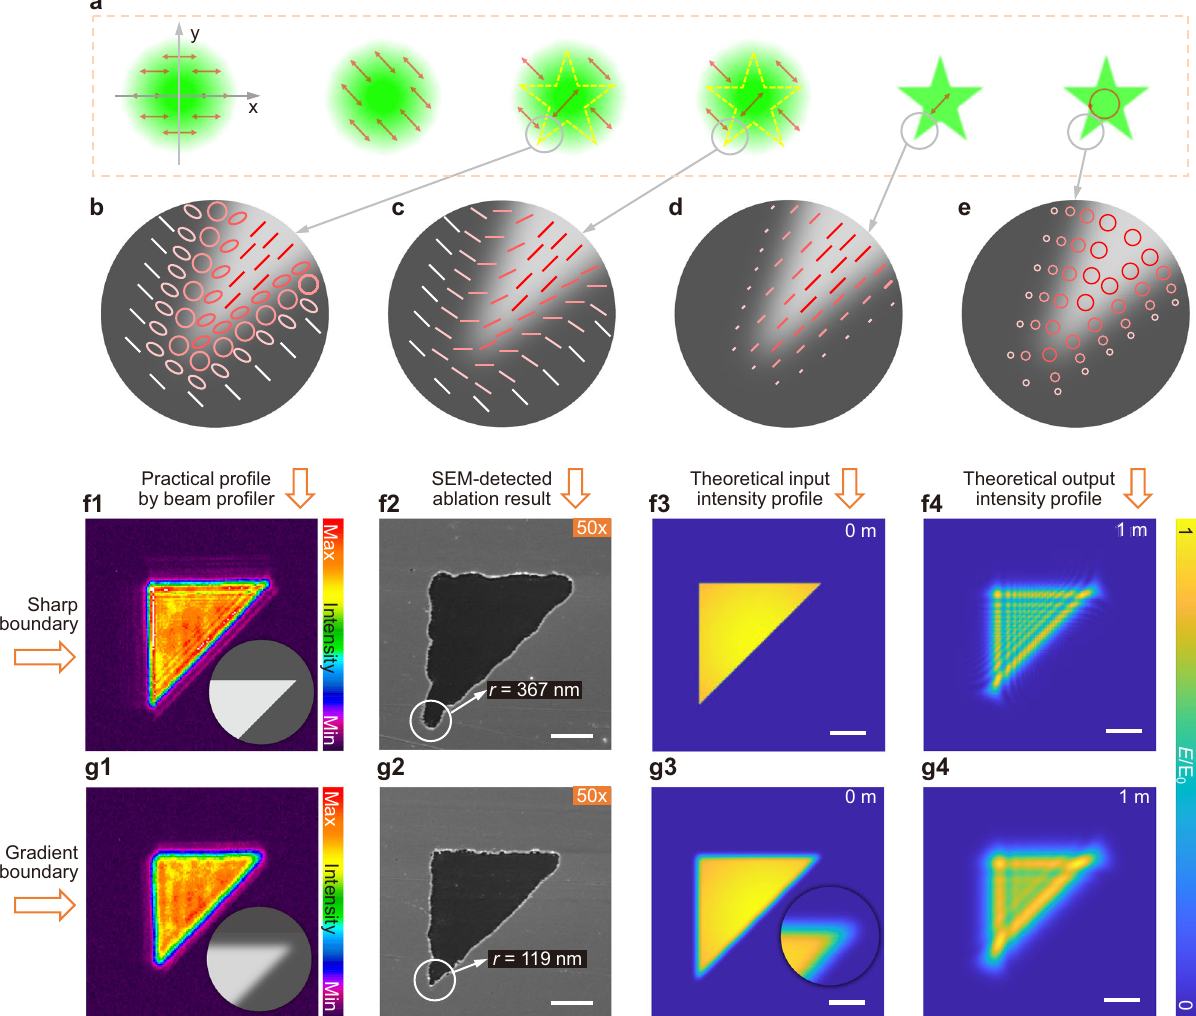
Fig.2|Theimprovementoffabricationmorphologybygradientgrayscaleson the pattern boundaries in the phase masks. a – e Schematic of the light mod- ulation process for PPLL resulting in patterned pulse with gradient boundary energy distribution. The arrows indicate the polarization direction. f , g The detected light intensity pro fi le with the phase mask inserted, SEM images of